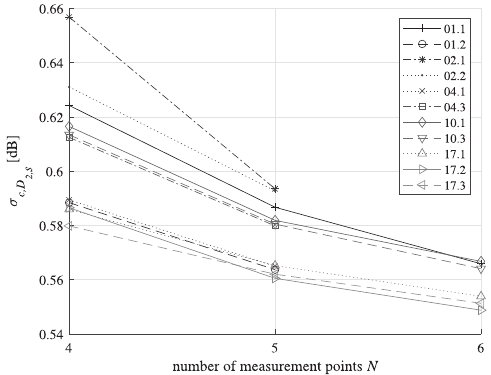
Figure 5. Decrease in combined uncertainty ^ r c ; D increasing number of measurement points N along the same measurement paths. Legend shows the number of the of fi ce followed by the number of the